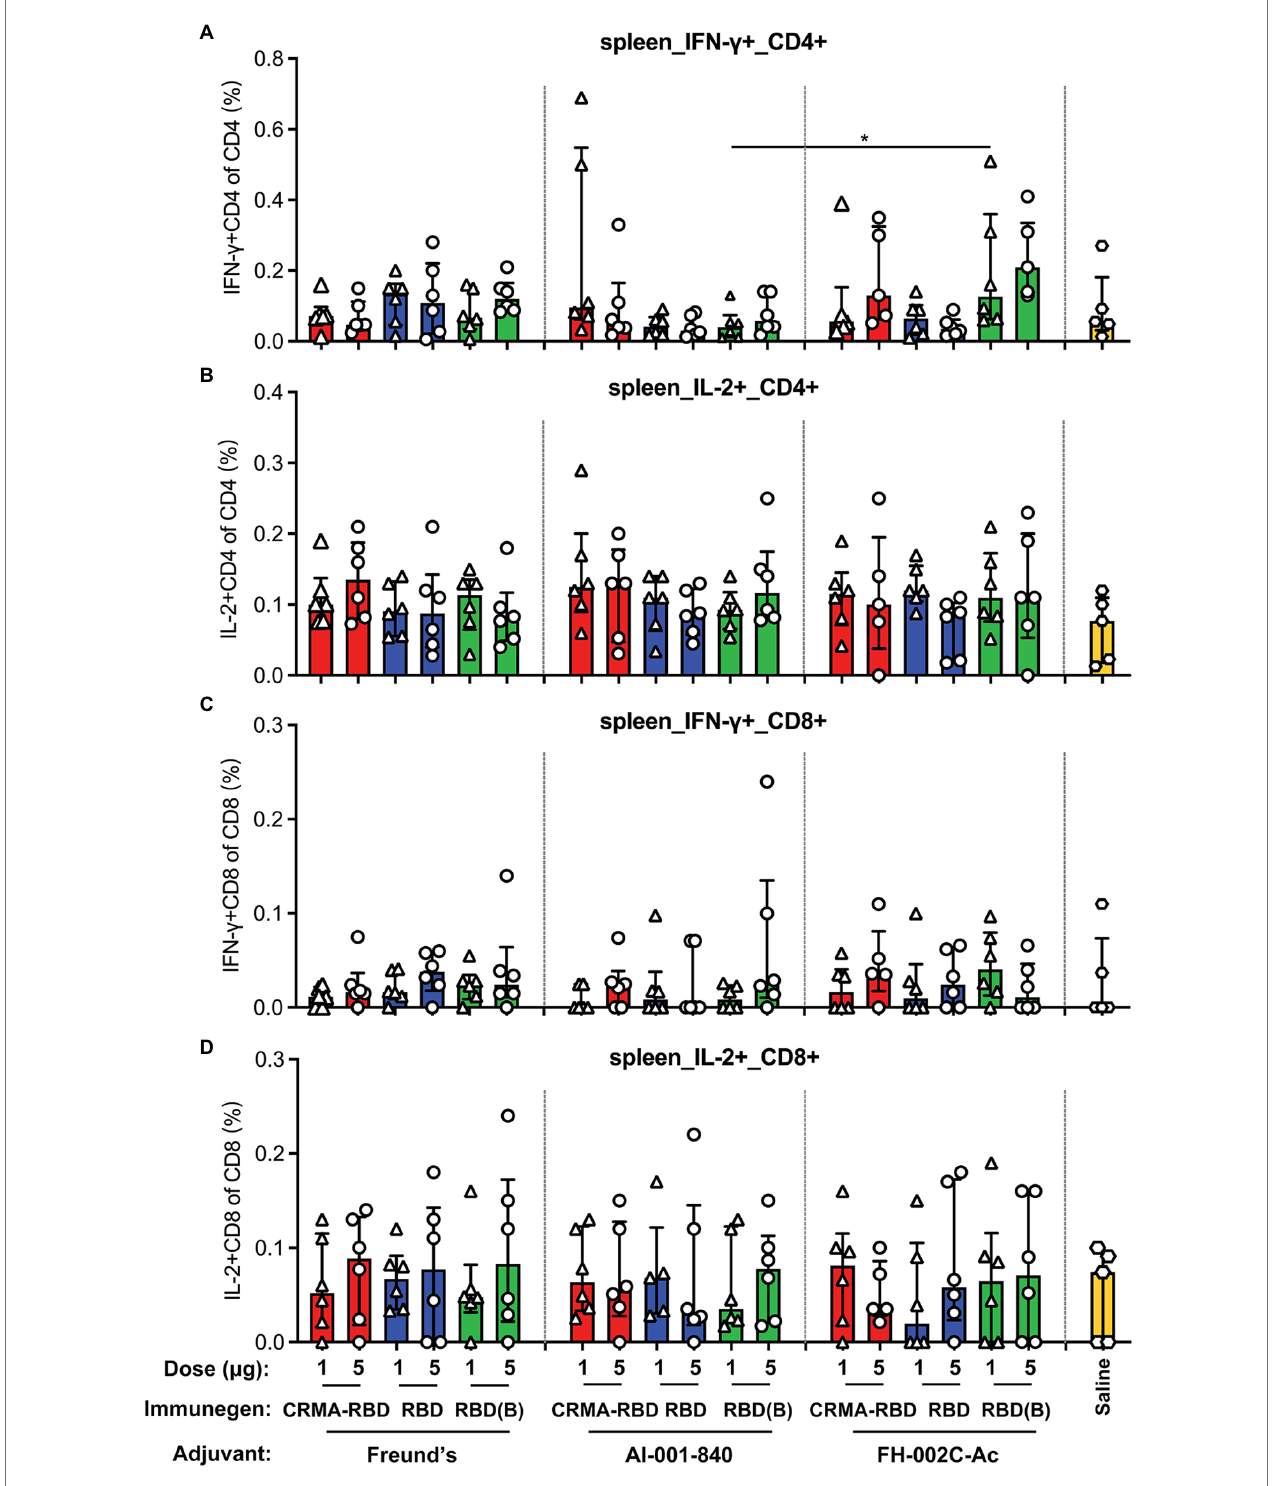
FIGURE 4 | T cell immune responses in BALB/c mice vaccinated with CRMA-RBD vaccine candidate. BALB/c mice ( n = 6) were immunized with CRMA-RBD, RBD, or RBD (Bac) vaccine candidates at two doses (1 and 5 μ g per dose) administered with Freund’s adjuvant, Alum adjuvant, or FH-002C-Ac adjuvant. Splenocytes were collected 7 days after the 3rd immunization and stained for fluorescence activated cell sorting (FACS). The frequencies of IFN- γ + CD4 + T cells (A) , IL-2 + CD4 + T cells (B) , IFN- γ + CD8 + T cells (C) , and IL-2 + CD4 + T cells (D) are plotted as median ± IQR. The statistical significance was determined by a Kruskal–Wallis test with Dunn’s multiple comparisons test. p values: * p < 0.05. RBD (B): RBD